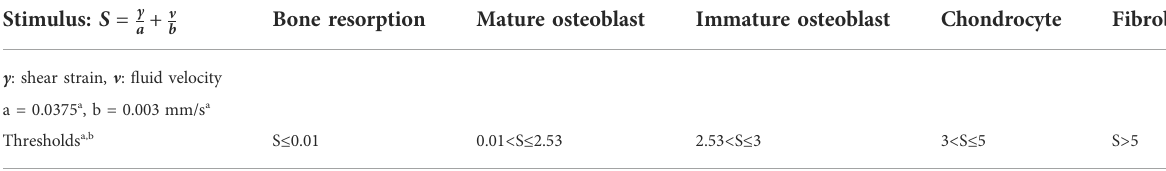
TABLE 2 Mechano-regulation algorithms for progenitor cell differentiation [adapted from (Checa et al., 2011)].